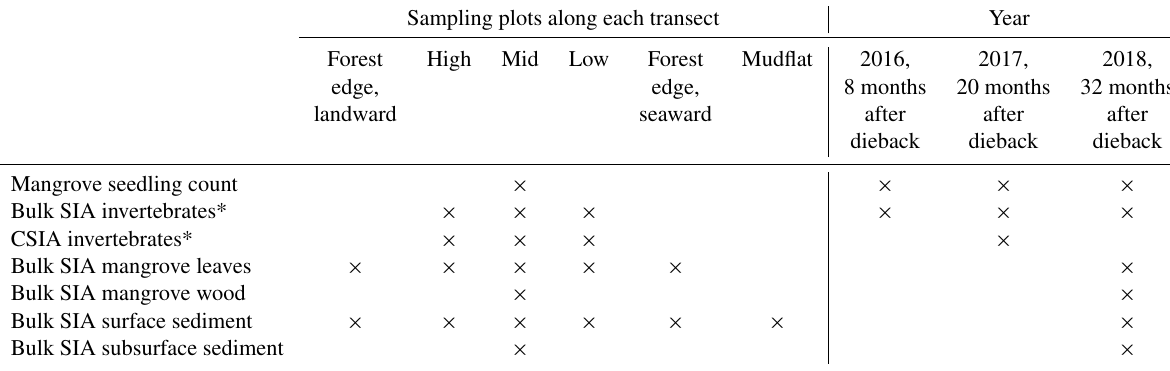
Table 1. Spatial and temporal details of the sampling design ( x = sampled). Sampling plots along each transect Forest High landward seaward after after after